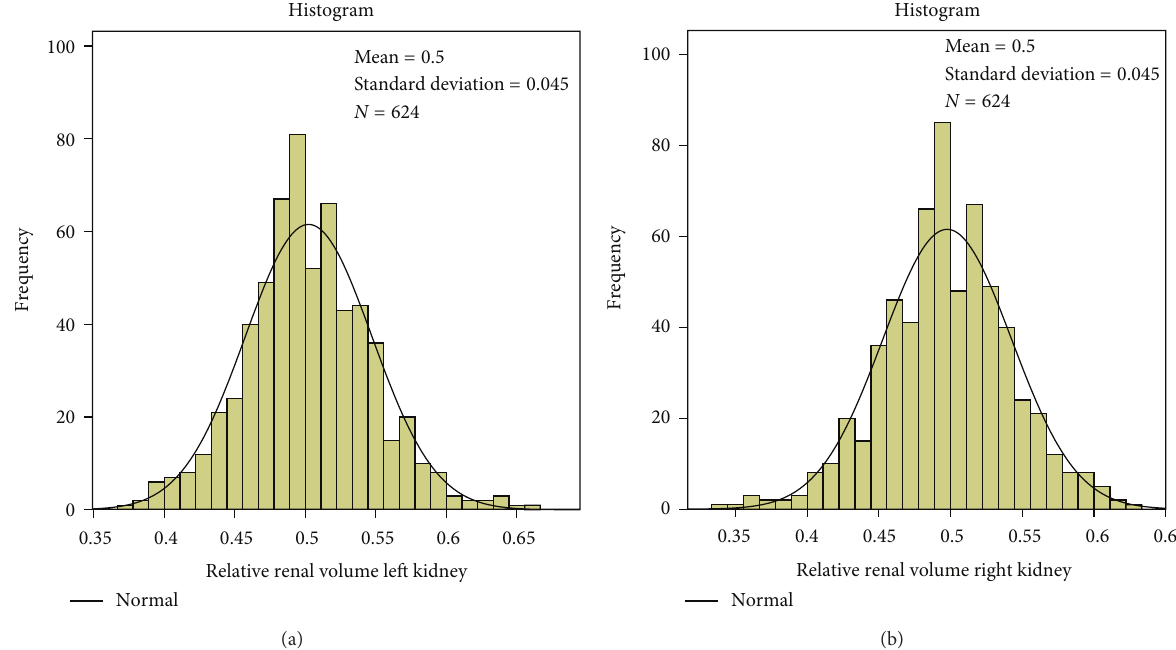
F 2: (a) Normal distribution of relative renal volume of the le kidney: mean = 0.50, N = 624, SD = 0.045. (b) Normal distribution of relative renal volume of the right kidney: mean = 0.50, N = 624. SD =